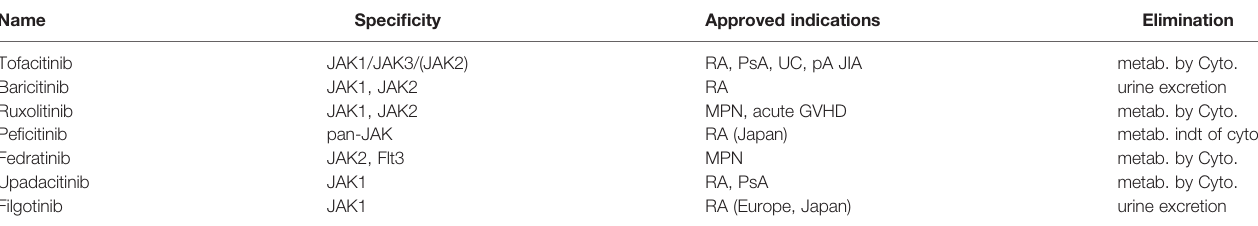
TABLE 2 | Approved marketed